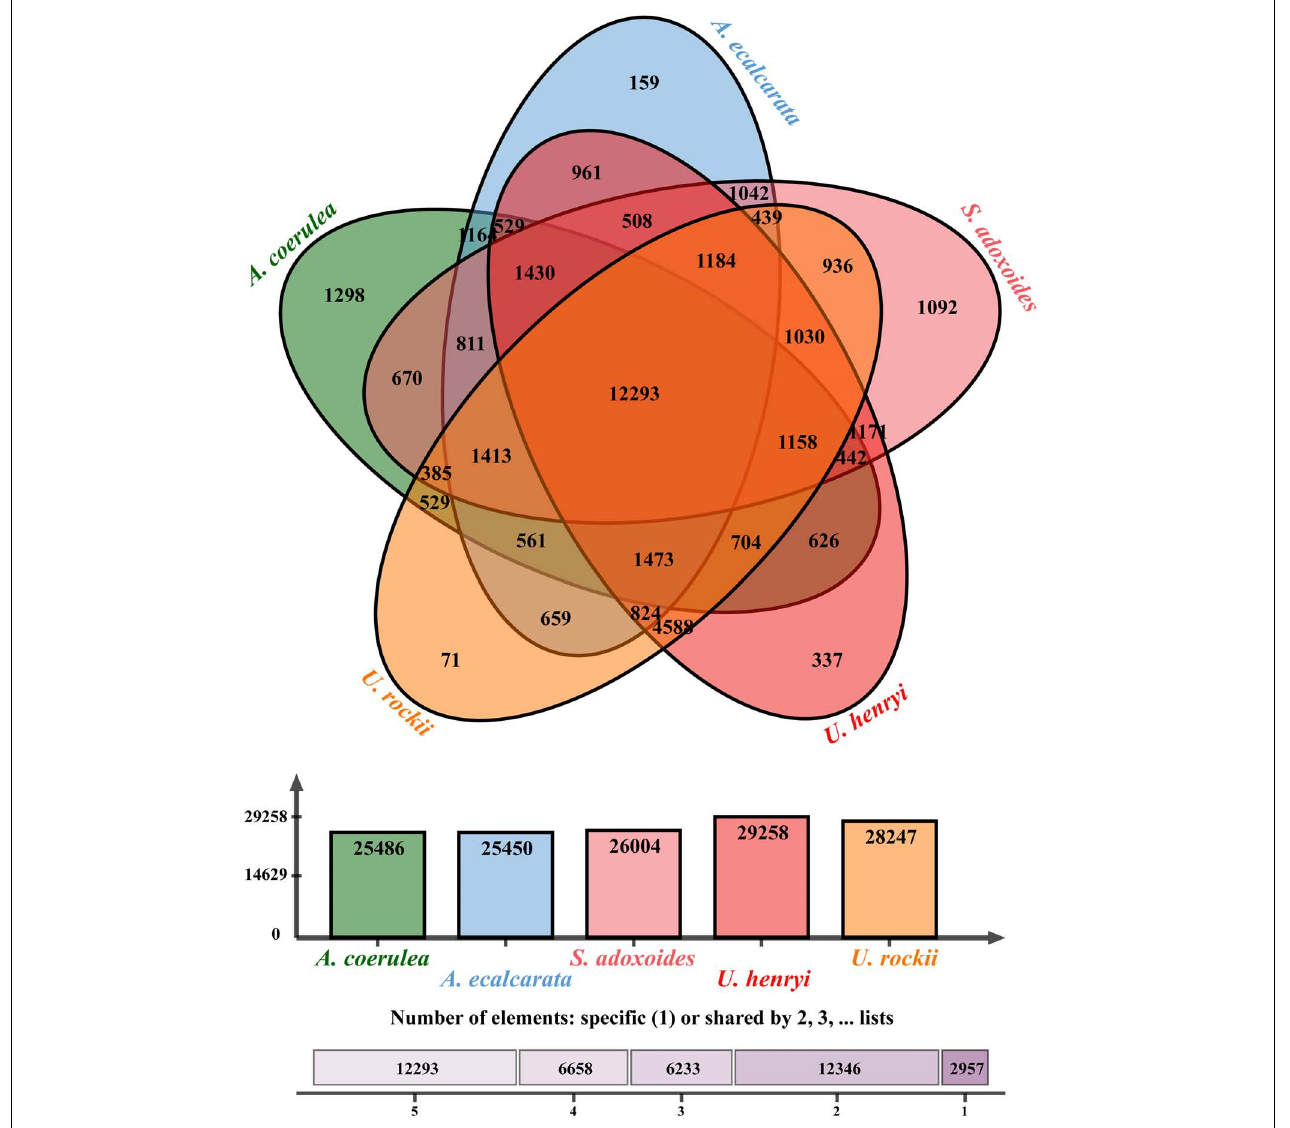
FIGURE 3 | Venn diagram showing the numbers of orthologs identified in genus Urophysa and close species using OrthoVenn2 (https://orthovenn2.bioinfotoolkits.